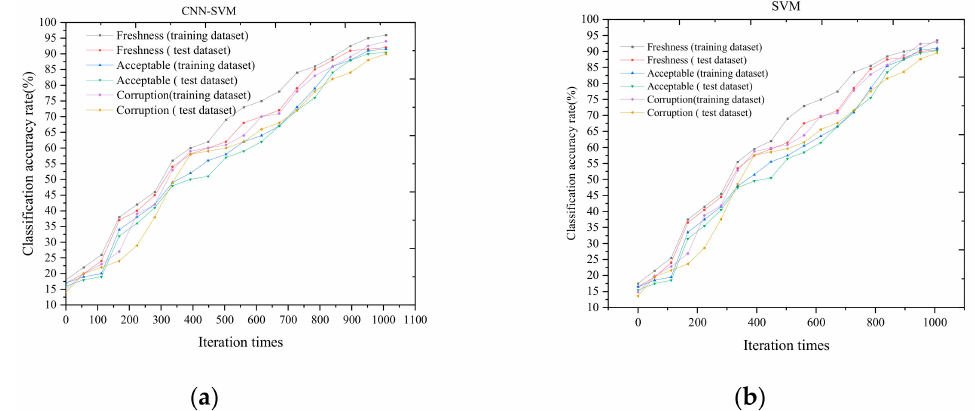
Figure 11. The freshness classification accuracy. ( a ) Convolutional Neural Networks and Support Vector Machine (CNN-SVM) based model classification accuracy rate; ( b ) Support Vector Machine (SVM)based model classification accuracy